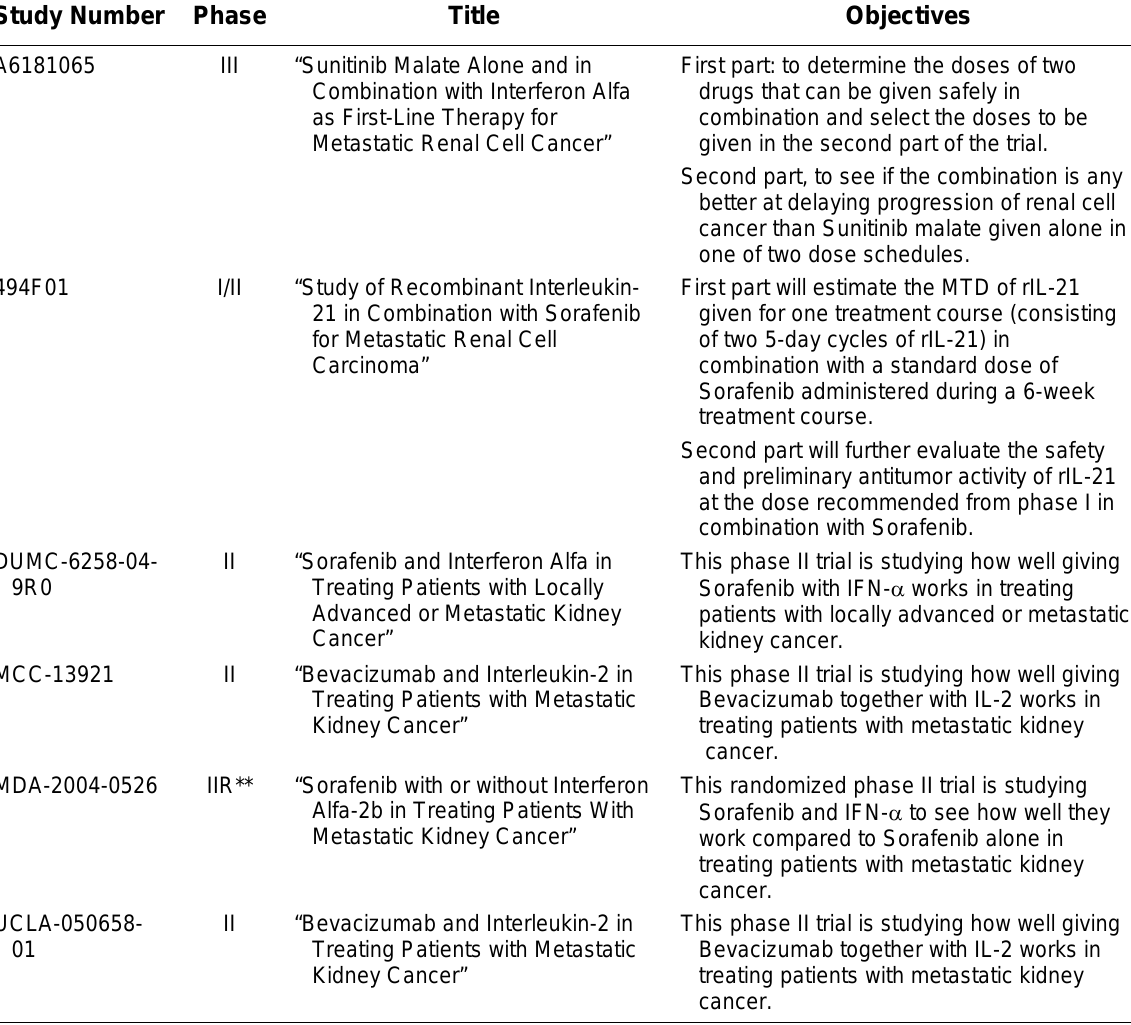
Ongoing U.S.-Based Combination Trials of Immunotherapy and Molecularly Targeted Drugs in Advanced RCC Patients, According to the NCI Trials